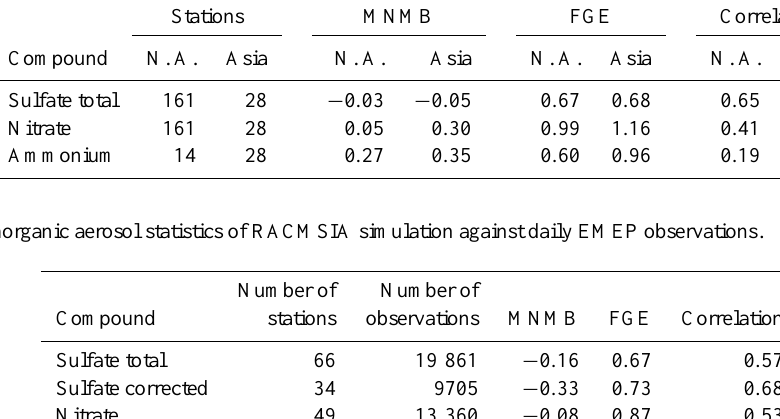
Table 11. Secondary inorganic aerosol compound statistics of the RACMSIA simulation against weekly HTAP observations; separation between North America (N. A.) and Asia.